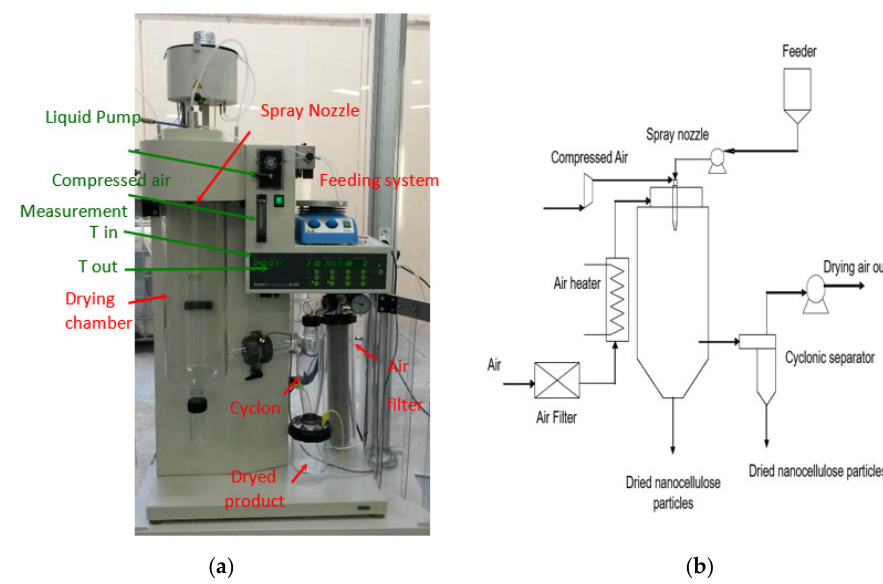
Figure 1. Atomization unit with indications of its components ( a ) and process scheme ( b ).